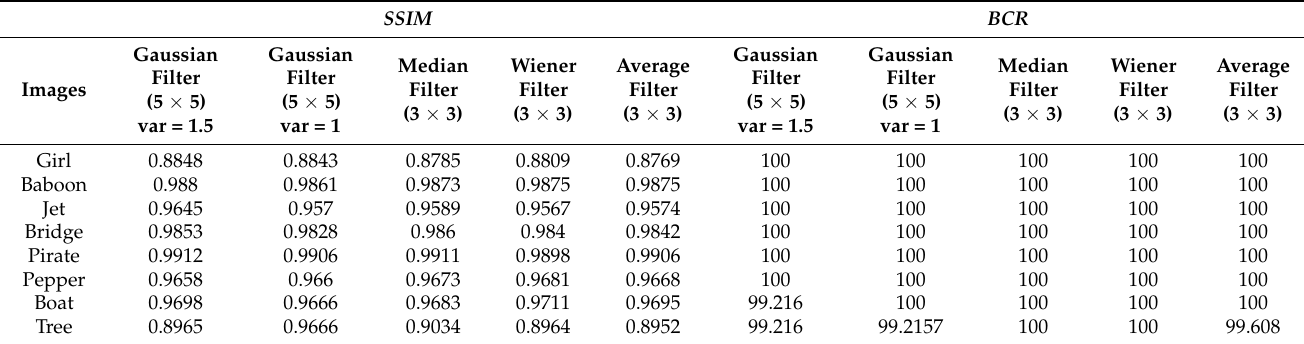
Table 8. Robustness against different filtering operations ( SSIM and BCR %).